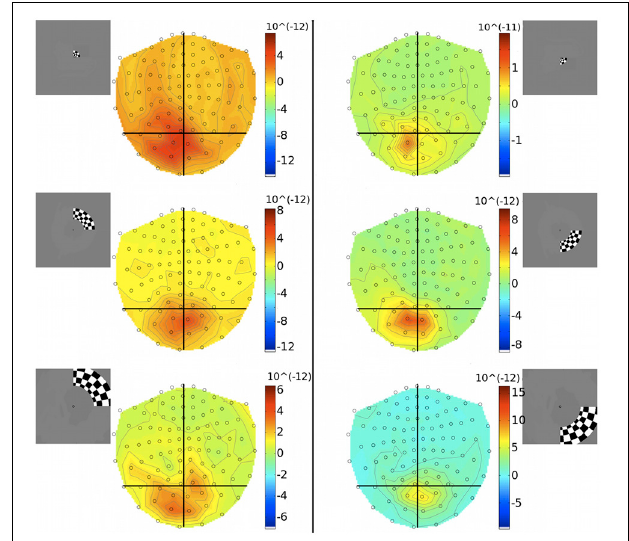
FIGURE 7 | Gradiometer topography maps (T/m) of the averaged evoked response to quarter-ring stimuli at 83ms post-stimulus (Subject 2). Left panels: show the responses to upper field quarter-ring stimuli. Quarter-ring eccentricities U-ECC 1, U-ECC 2, and U-ECC 3 are presented at the top, middle, and bottom, respectively. Right panels: show the responses to lower field quarter-ring stimuli. Quarter-ring eccentricities L-ECC1, L-ECC2, and L-ECC3 are presented at the top, middle, and bottom, respectively. Insets indicate stimulus locations.